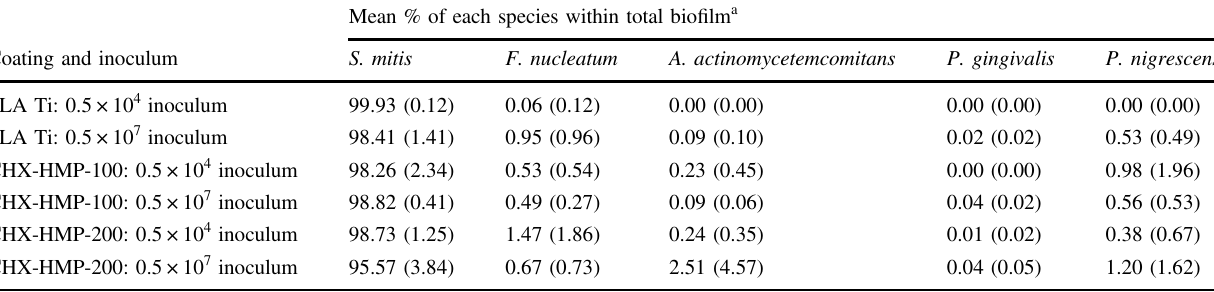
a Percentage composition by gDNA mass. Figures in brackets indicate standard deviation. No signi fi cant differences between coating type or inocula for any species, as determined by 1-way ANOVA with Sidak post hoc ( n =